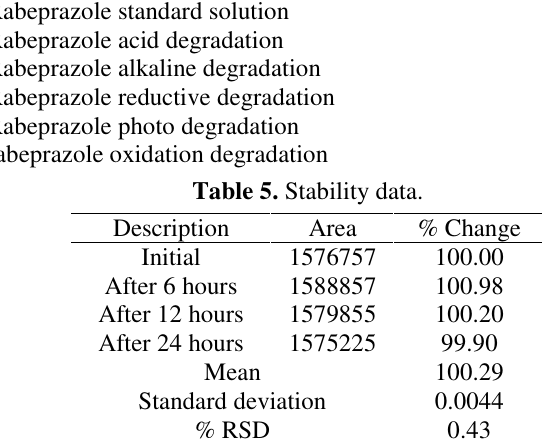
Figure 3. Chromatograms depicting the specificity of rabeprazole (40 µg/mL)